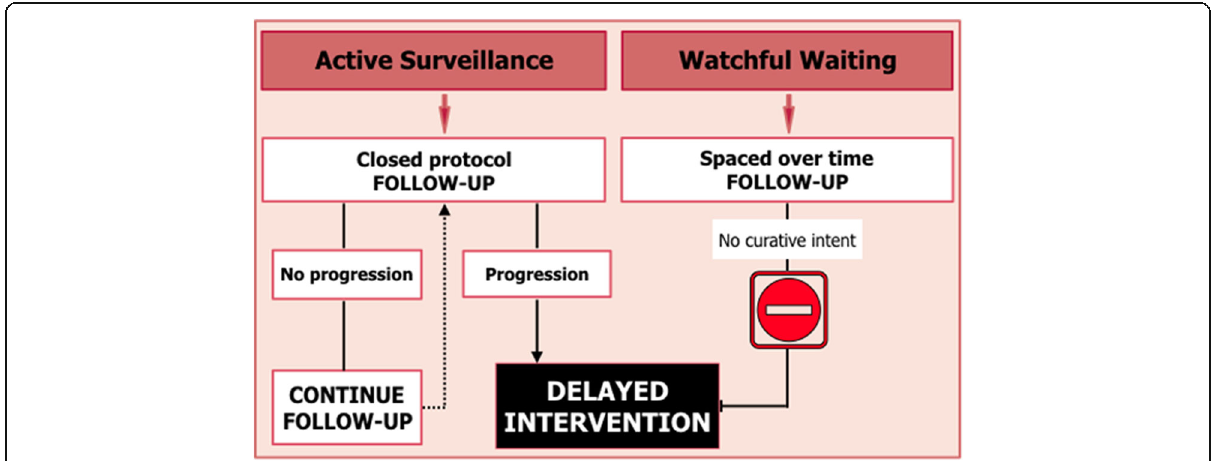
Fig. 2 The main differences between active surveillance (AS) and watchful waiting (WW) in the monitoring of small renal masses. Active surveillance is defined as the initial management including the monitoring of renal tumor size by serial imaging with delayed treatment in case of progression. In WW, close monitoring with imaging techniques is not routine, curative treatment is not administered, and active treatment is only indicated on the appearance of